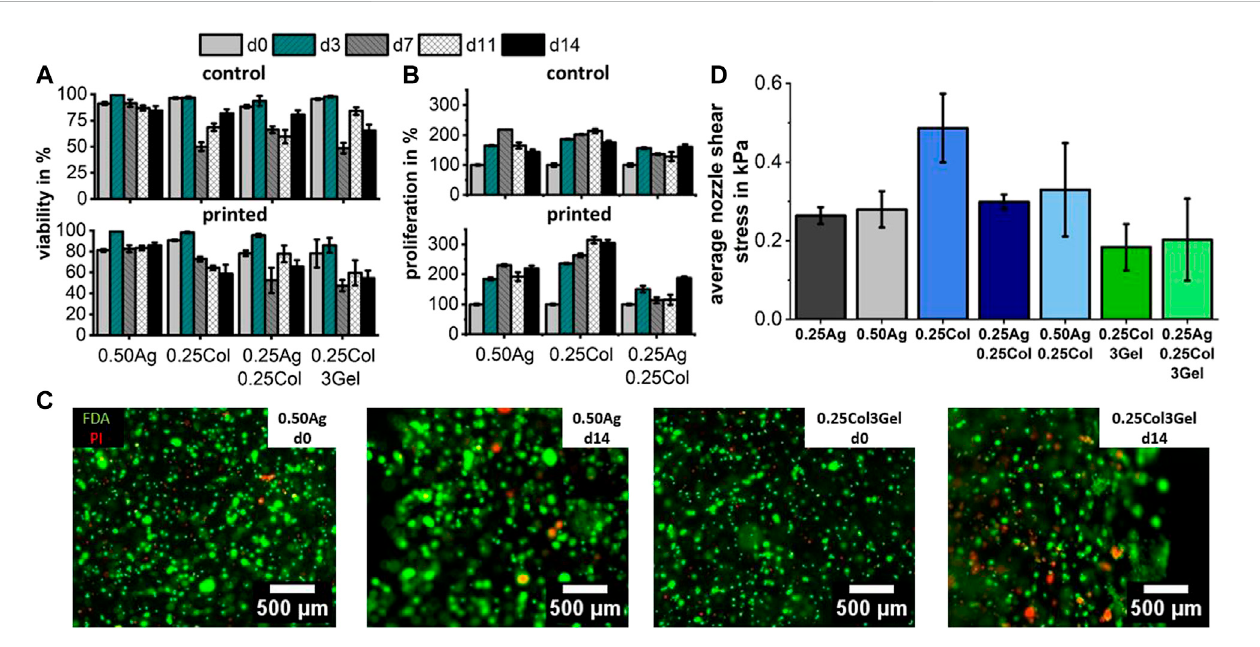
FIGURE 7 Cell viability (A) and proliferation (B) for 1 × 10 6 cells/ml HepG2 cells in agarose, collagen and gelatin blends both after printing and for a control group.FluorescenceimagesofbioprintedHepG2stainedwithFDAforlive(green)andPIfordead(red)cellsshownonegativeeffectofprintingoncellviability after14 daysinculture (C) ,whichcorrespondstothelownozzleshearstressthatcellsencounterduringprinting (D) .Cellviabilityandproliferationwerefound unsigni fi cant between printed and control group, except for viability in 0.25Col3Gel ( p < 0.01); n = 3.